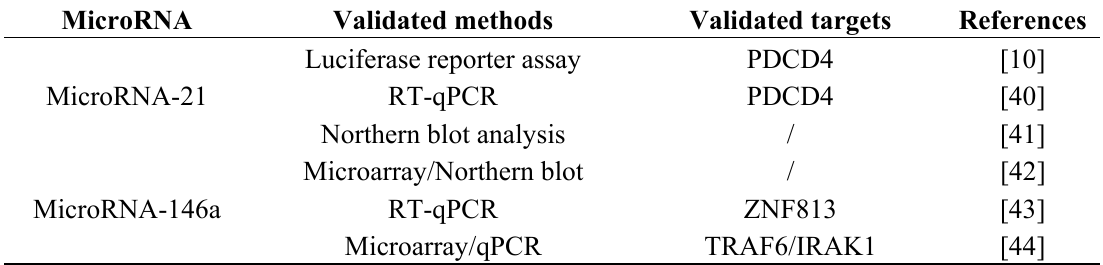
Table 1. Cervical cancer-associated microRNAs used in this